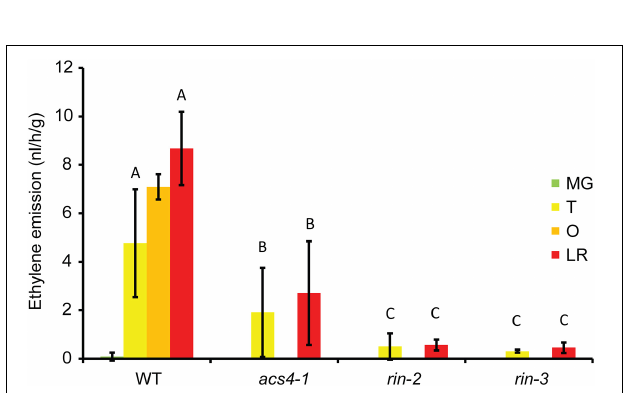
aminotransferase class I/classII domain (IPR004839); blue: the cofactor binding site (IPR004838); green: MADS-box domain (IPR002100); orange: K-box (IPR002487). (C) RT-PCR showing reduced length of the rin-3 transcript. The 100-, 200- and 300-bp bands of the DNA marker are shown.